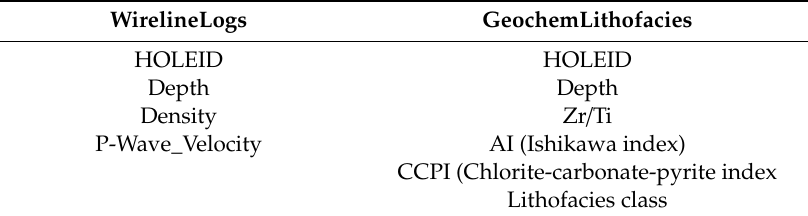
where * refers to a wildcard character used for the selection of all database